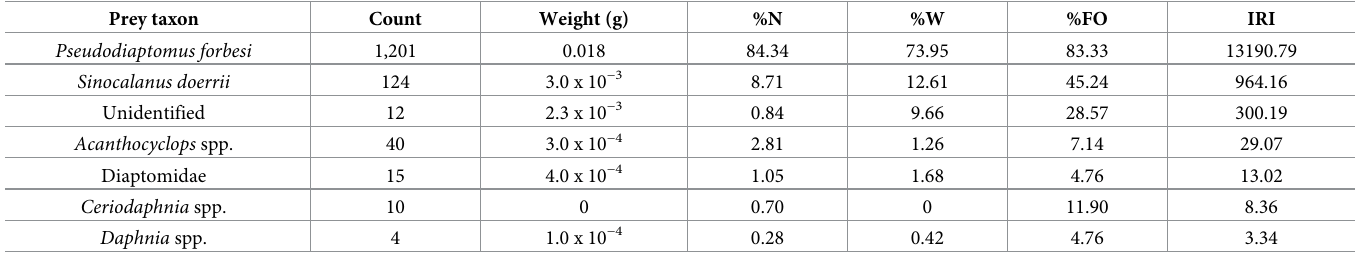
Table 3. Summary of diet composition information from juvenile Delta Smelt collected in the Yolo Bypass Toe Drain (N = 42). %N is percent of prey taxon by num- ber, %W is percent of prey taxon by weight, %FO is frequency of occurrence, and IRI is index of relative importance. Prey